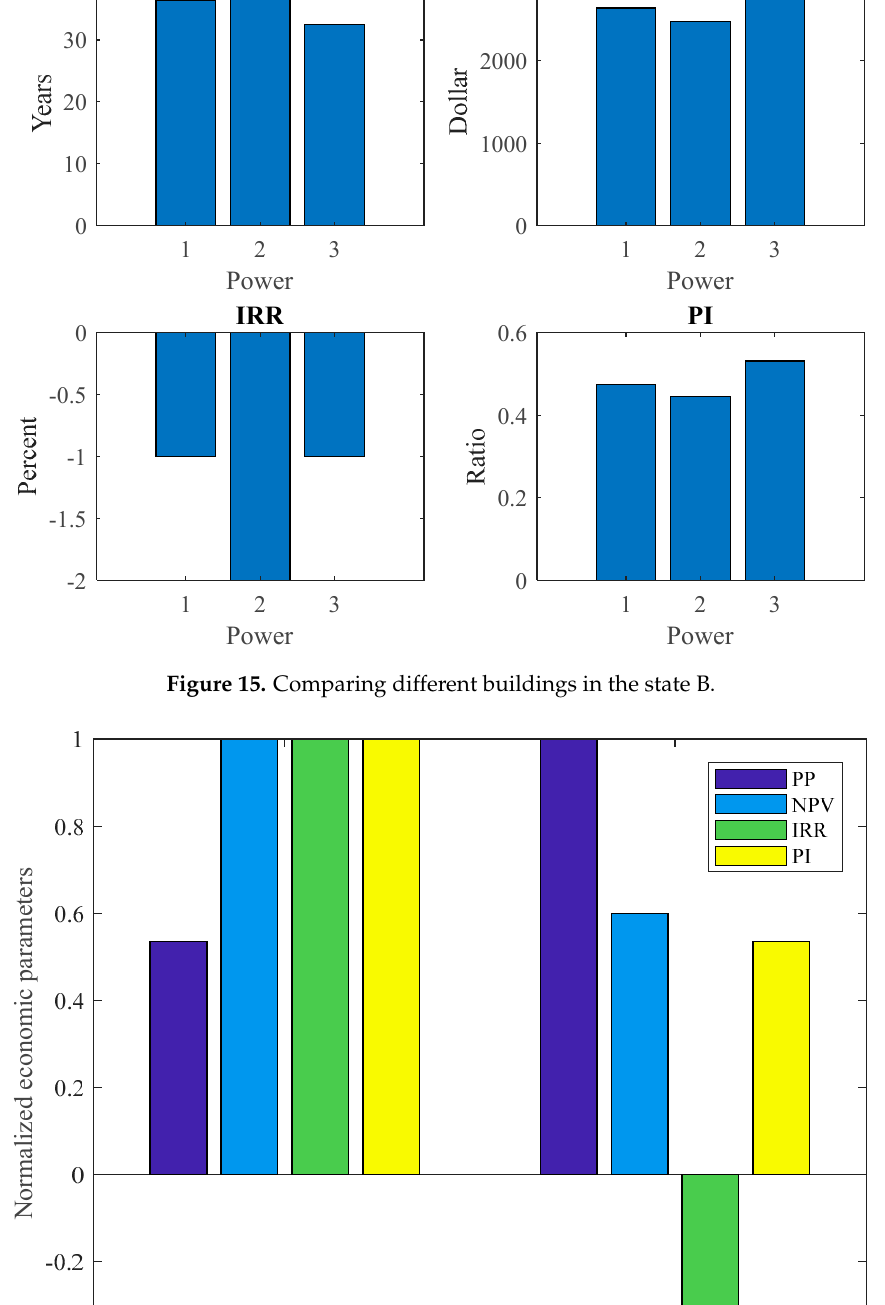
Figure 16. Compare the economic justification of two states. (1) State A (2) State B.